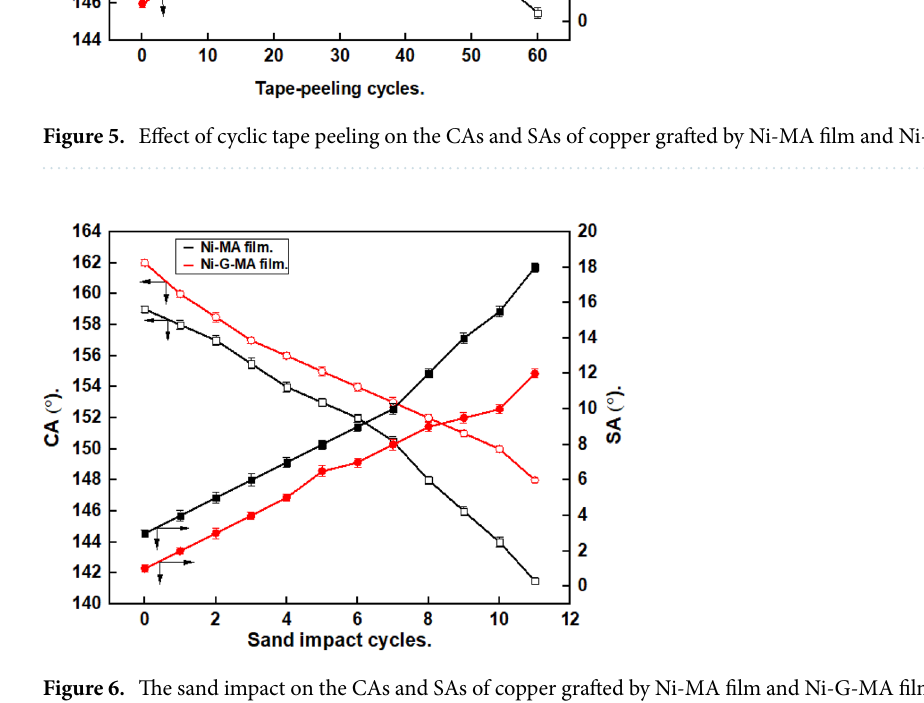
Figure 6. The sand impact on the CAs and SAs of copper grafted by Ni-MA film and Ni-G-MA